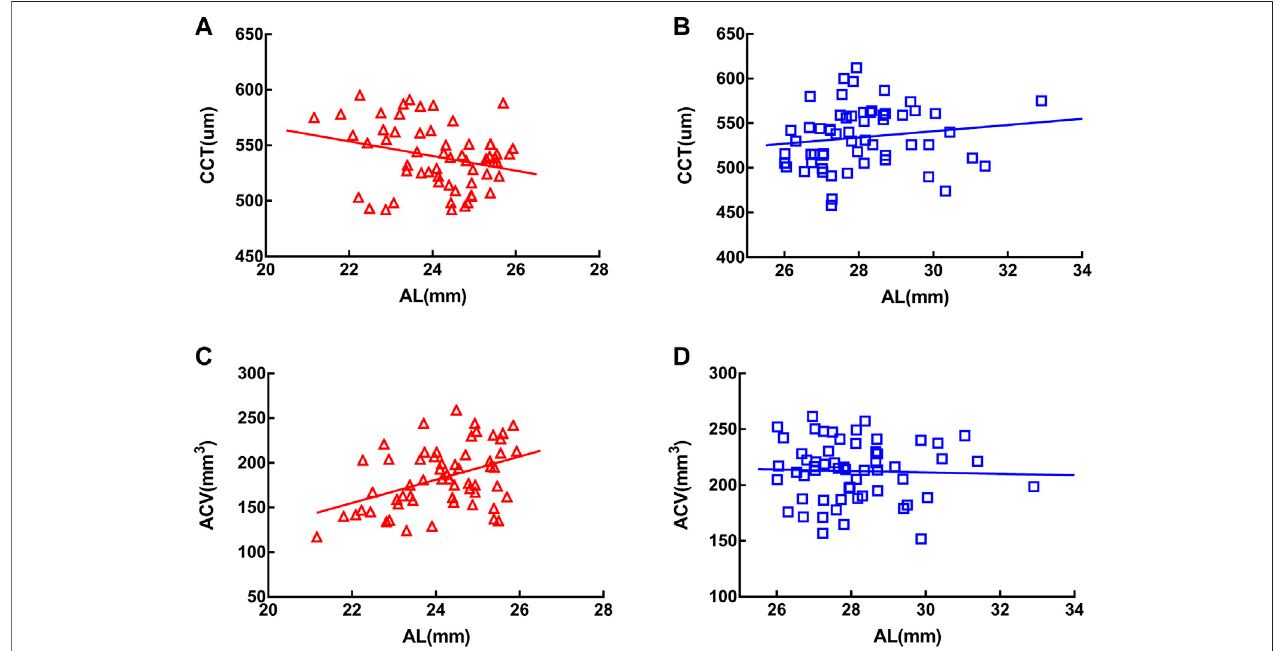
FIGURE3| Centralcornealthickness(CCT)wasnegativelycorrelatedwithaxiallengthinthemoderatelyelongatedeyegroup( r (cid:1) − 0.289, p < 0.05) (A) andanterior chamber volume (ACV) was positively correlated with axial length ( r (cid:1) 0.444, p < 0.001) (C) . In the severely elongated eye group, neither CCT (B) nor ACV (D) was associated with axial length ( p > 0.05).